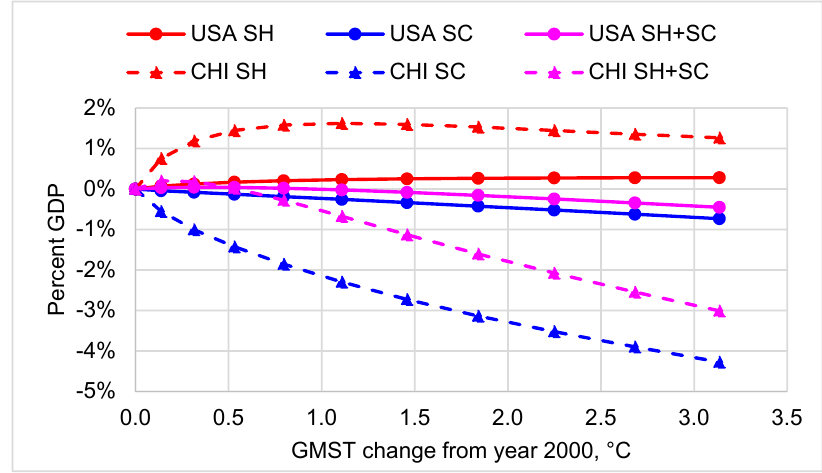
Figure 12. USA and CHI, heating, cooling and heating plus cooling economic impact (percent of GDP) versus GMST change from 2000, with non-temperature drivers a function of time.